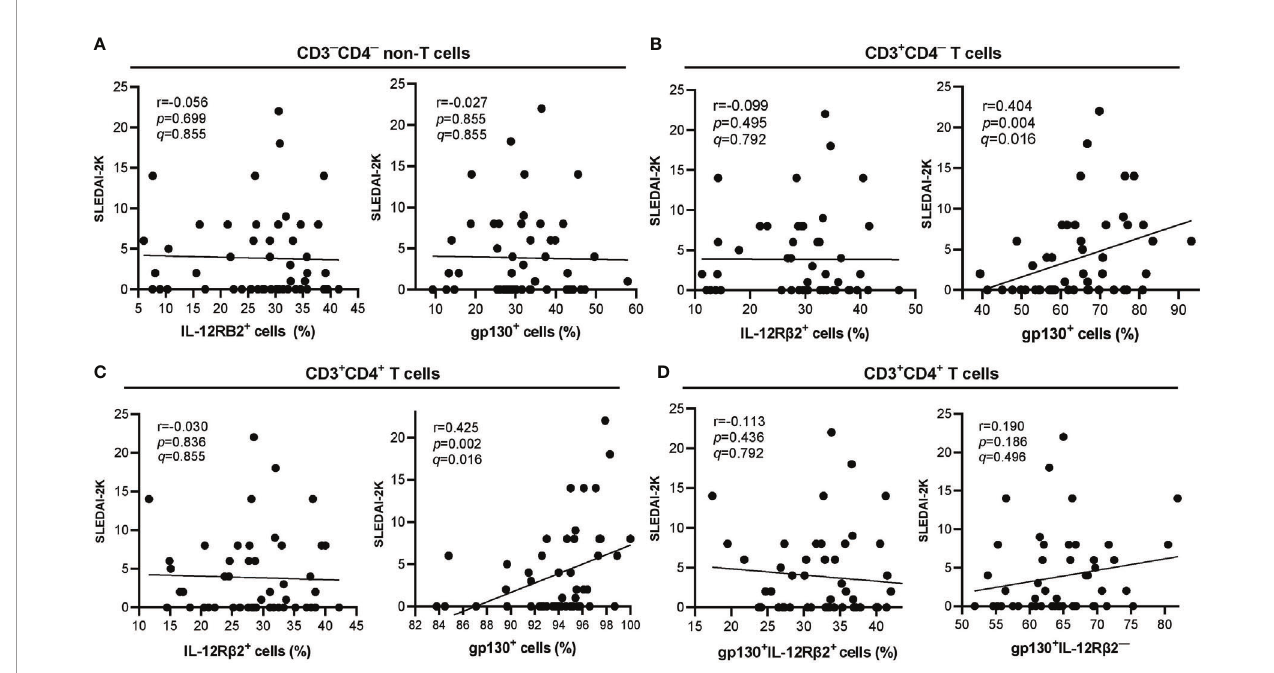
FIGURE 4 | Correlation of lymphocyte subpopulations expressing surface IL-12R b 2 or gp130 (in percentage) with SLEDAI-2K scores in SLE patients (n=50). (A) Correlation of CD3 ─ CD4 ─ non-T cells expressing surface IL-12R b 2 + (left) or gp130 + (right) with SLEDAI-2K scores. (B) Correlation of CD3 + CD4 ─ T cells expressing surface IL-12R b 2 + (left) or gp130 + (right) with SLEDAI-2K scores. (C) Correlation of CD3 + CD4 + T cells expressing surface IL-12R b 2 + (left) or gp130 + (right) with SLEDAI-2K scores. (D) Correlation of CD3 + CD4 + T cells expressing surface gp130 + IL-12R b 2 + (left) or gp130 + IL-12R b 2 ─